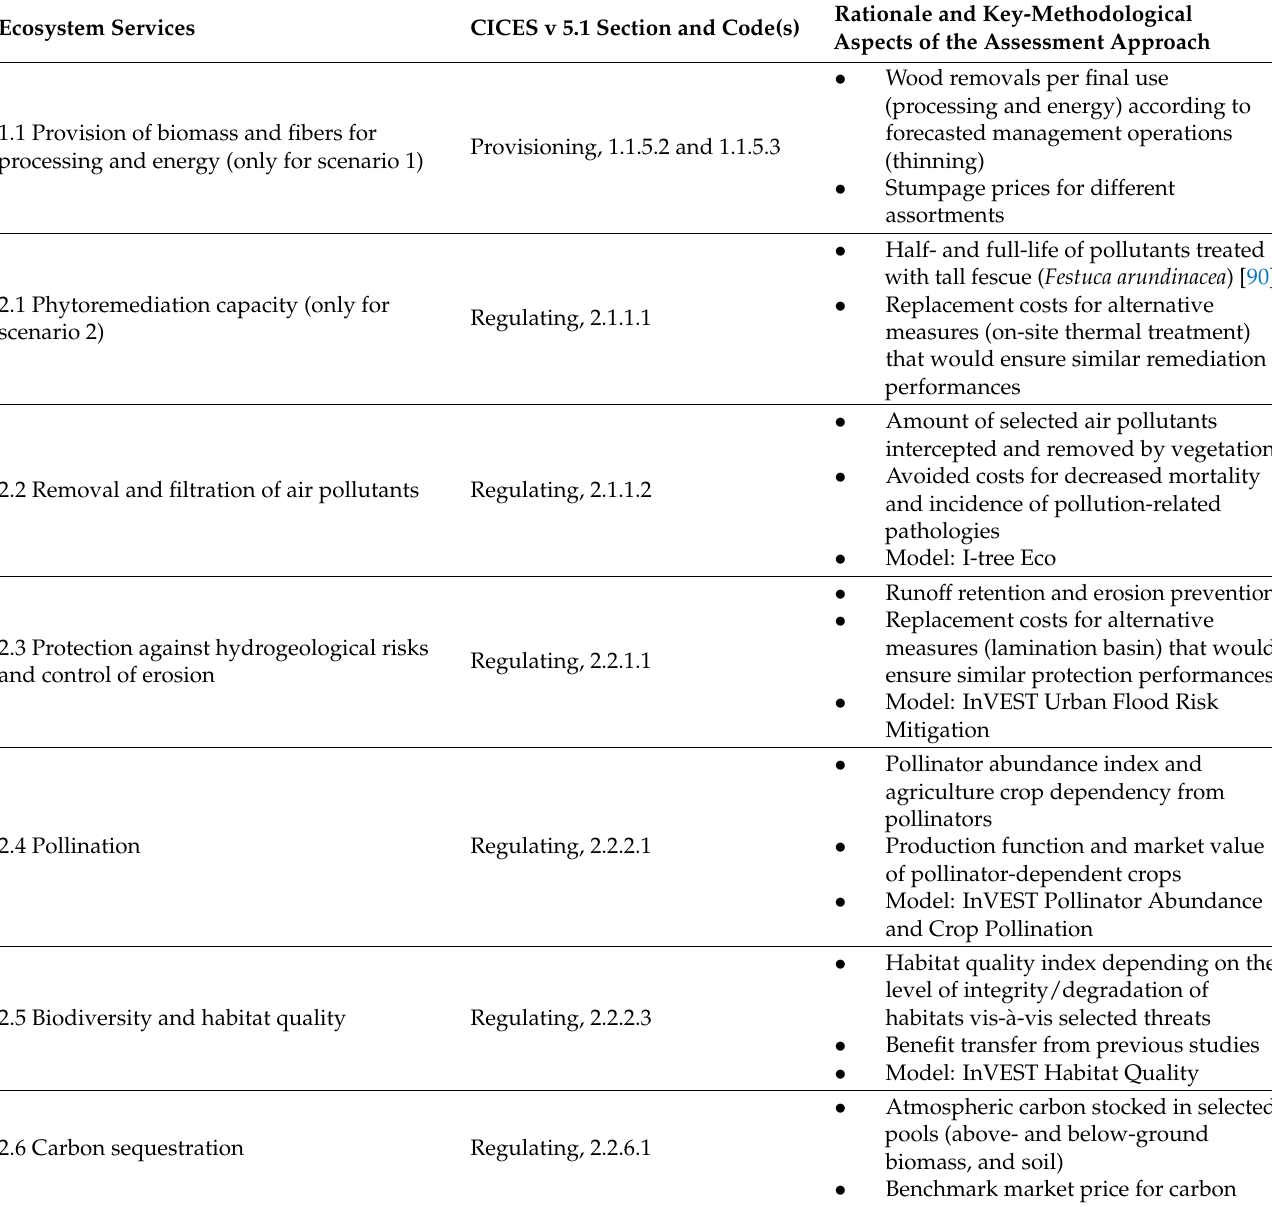
Table 2. Overview of ecosystem services targeted by the research and assessment